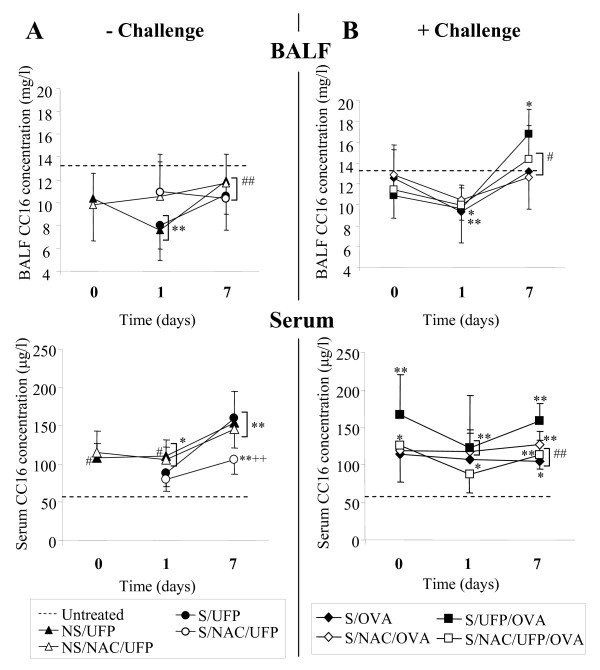
BALF and serum CC16 concentration. (A) Non sensitized (NS/UFP) and sensitized (S/UFP) mice exposed to EC-UFP, and treated with NAC (NS/NAC/UFP and S/NAC/UFP, respectively); (B) Sensitized and challenged mice (S/OVA), treated with NAC (S/NAC/OVA), or exposed to EC-UFP 24 h prior to OVA challenge (S/UFP/OVA), and treated with NAC (S/NAC/UFP/OVA). NAC treatment was performed prior to and close to mid EC-UFP exposure. Untreated mice served as baseline controls (dotted line). Data presented as mean ± SD (n = 4-7/time point). *p < 0.05, **p < 0.01 vs untreated; ++p < 0.01 vs S/UFP;#p < 0.05, ##p < 0.01 NS/UFP, S/UFP, S/OVA, S/NAC/UFP/OVA vs S/UFP/OVA.